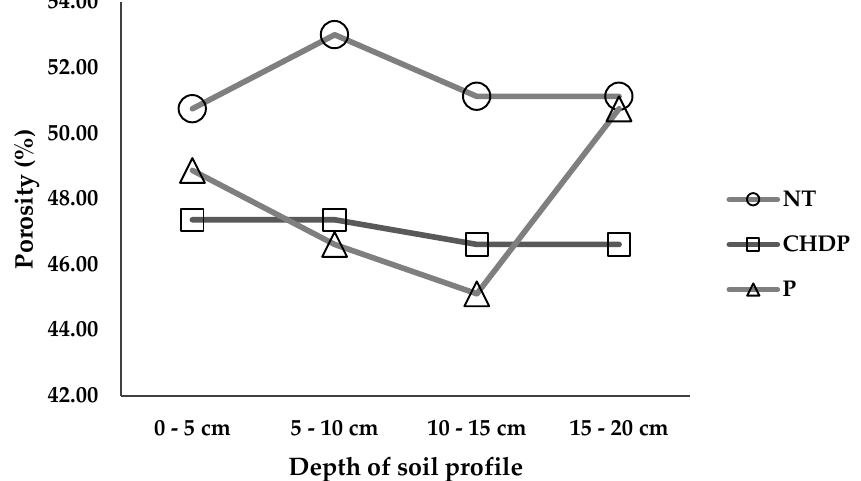
Figure 9. Soil porosity at intervals of 5 cm after three years of the tillage treatments in 2016.